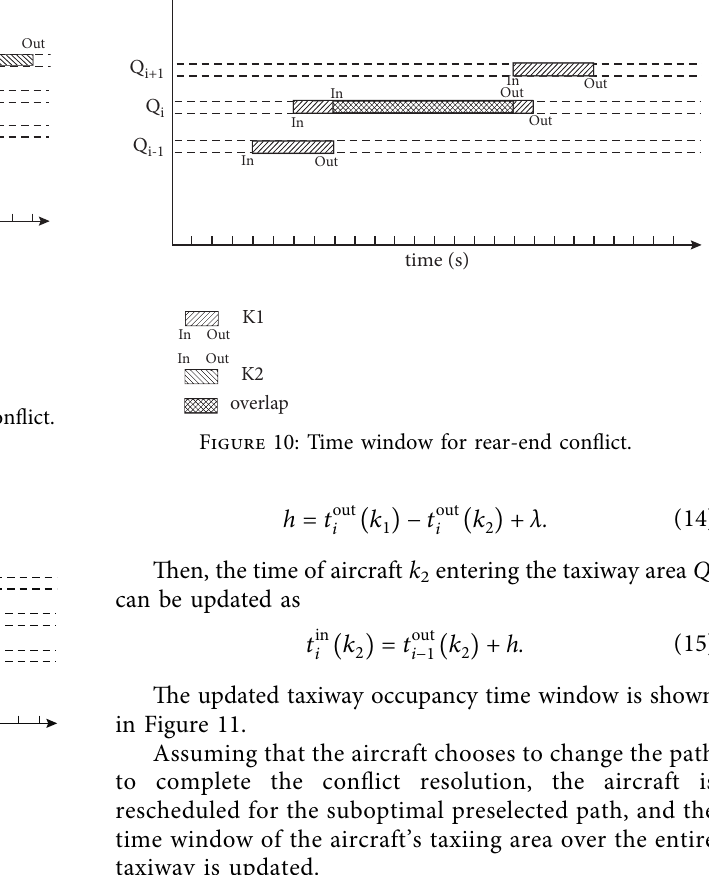
Figure 8: Time window for cross-conflict.